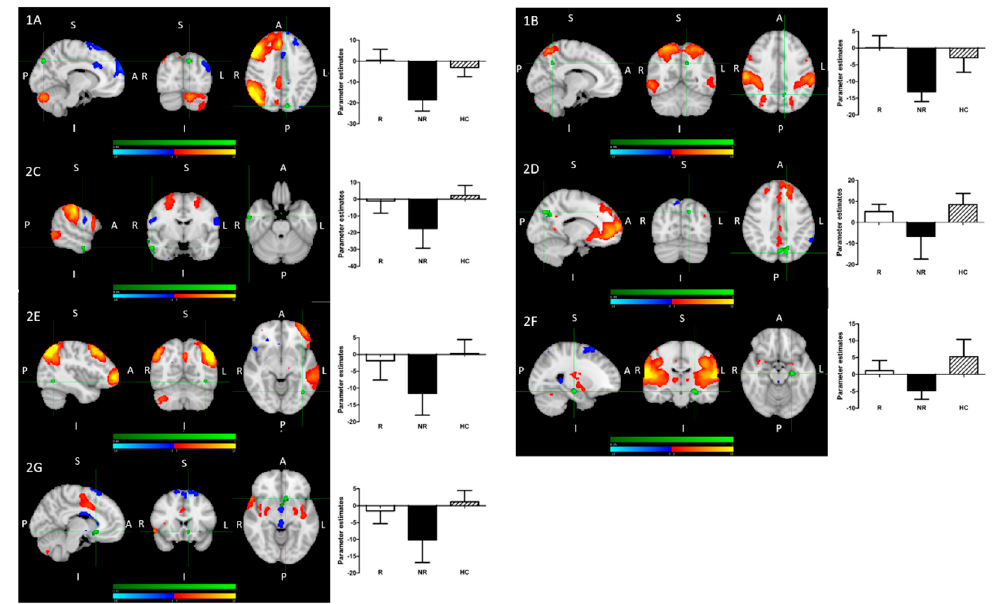
Figure 2. Pre-treatment resting-state functional connectivity in treatment responders, non-responders and healthy controls. Significantly greater temporal correlation (coherence) of activity between individual networks (red-yellow) and clusters (green), differentiating the groups, is shown in the left panels. The networks and regions are described in detail below and in Table 2. Parameter estimates, representing the value of temporal correlation for individual groups, are shown on the graphs directly to the right of the corresponding brain map. Table 2. Differences in functional connectivity (temporal correlations) between resting state networks and individual brain regions. Individual clusters identified with each contrast shown. Resting state data TFCE-corrected FWE cluster significance level of p < 0.05.